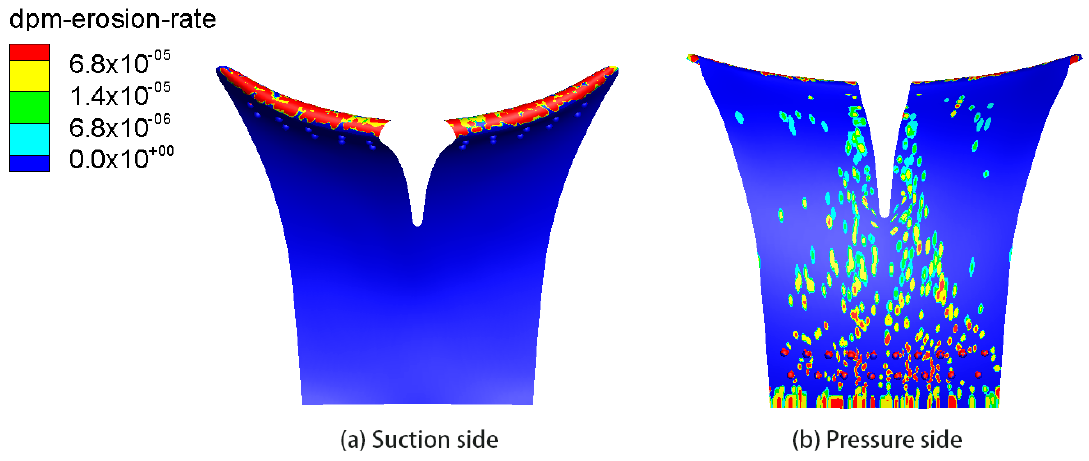
Figure 22. Silt erosion on blade surface with bionic convex domes (units: μ m/s, silt concentration: 6.5 kg/m 3 ).